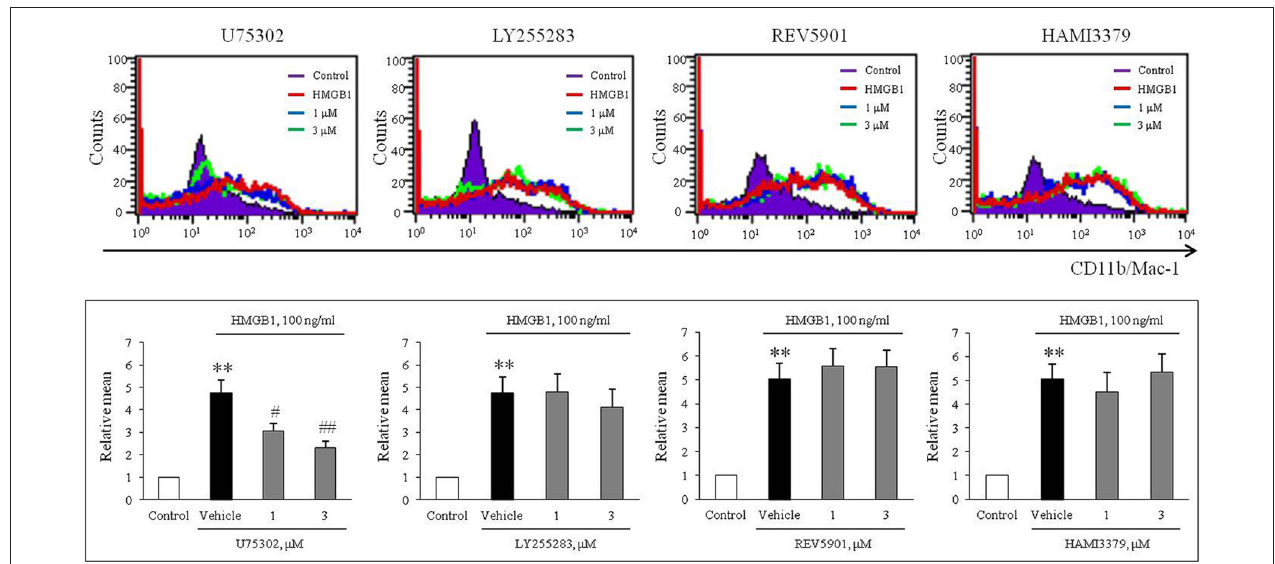
FIGURE 2 | A potential role of BLTR1 signaling in monocytes on HMGB1-induced MMD. Representative flow cytometric images of CD11b/Mac-1 expression in BMDCs treated with HMGB1 (100ng/ml) in the presence or absence of inhibitors for BLTR1 (U75302), BLTR2 (LY255283), cysLTR1 (REV5901), and cysLTR2 (HAMI3379). Bottom: Surface expressions of CD11b/Mac-1 on macrophages were expressed as mean fluorescent intensities. Quantified data were presented as the means ± SEMs of 7–8 independent experiments. ** P < 0.01 vs. control, # P < 0.05; ## P < 0.01 vs. vehicle.